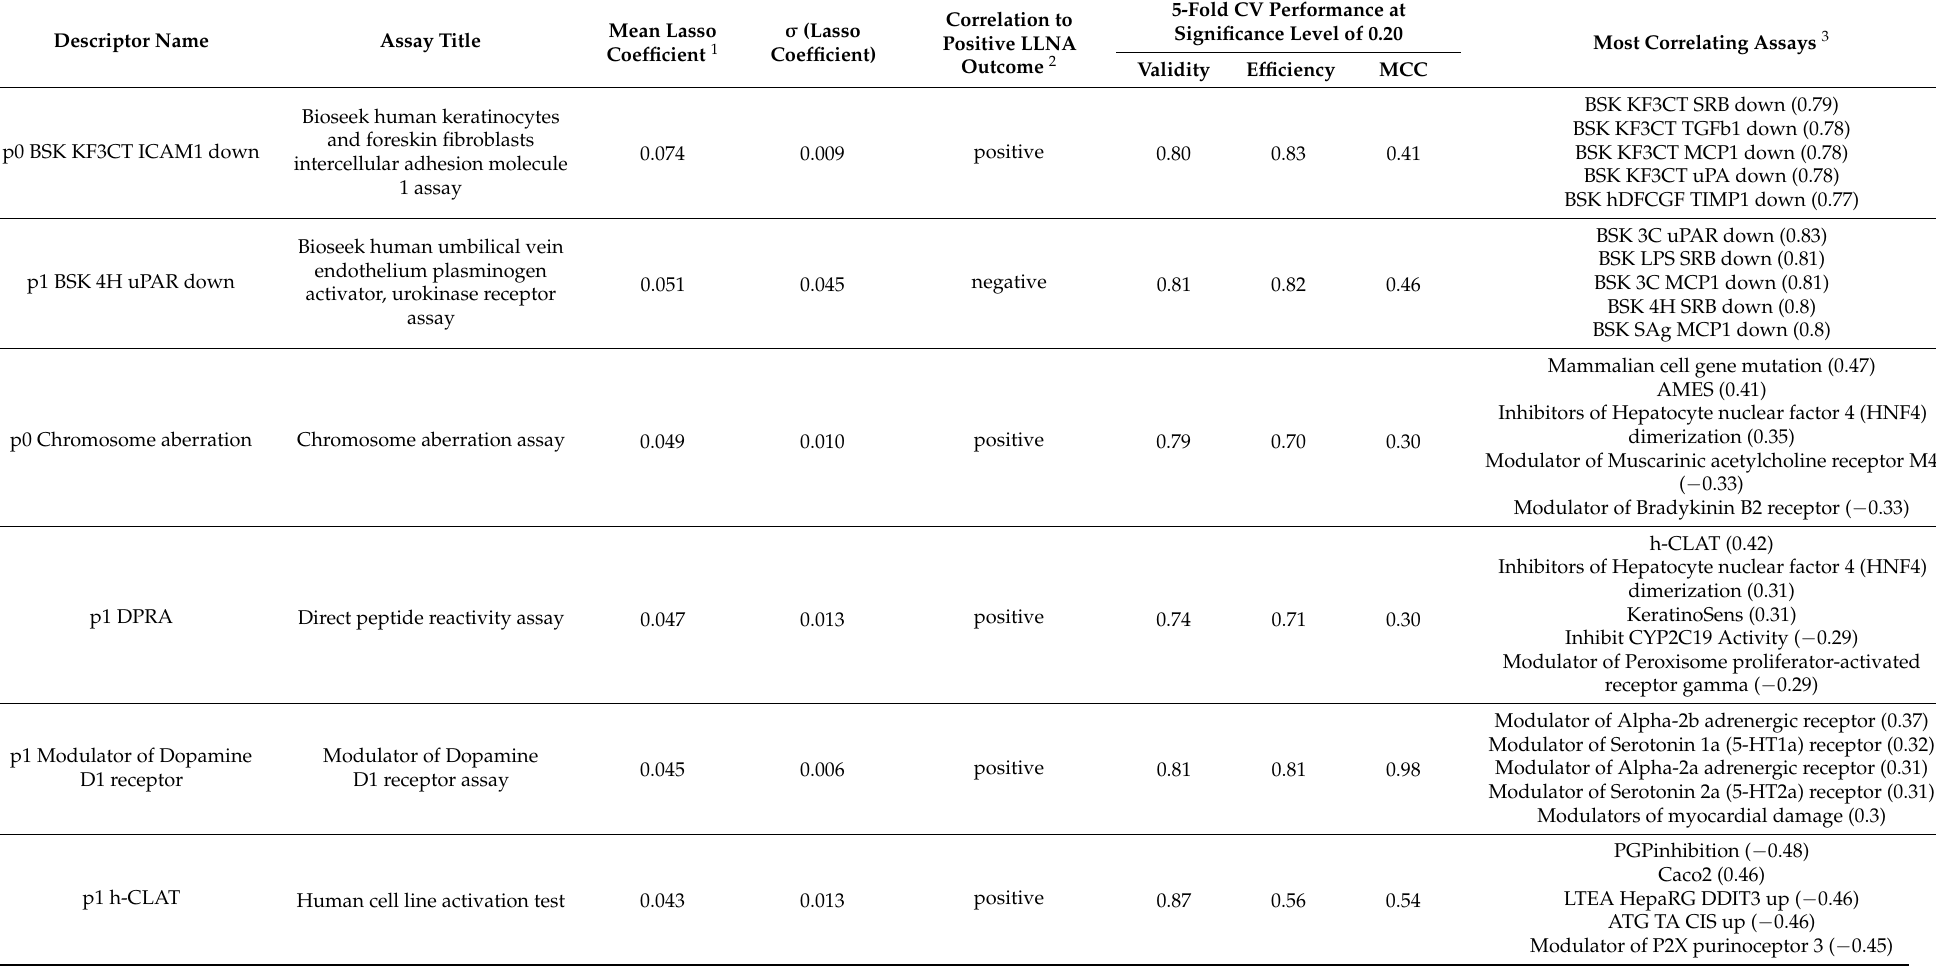
Table 2. Overview of the Top-10 Bioactivity